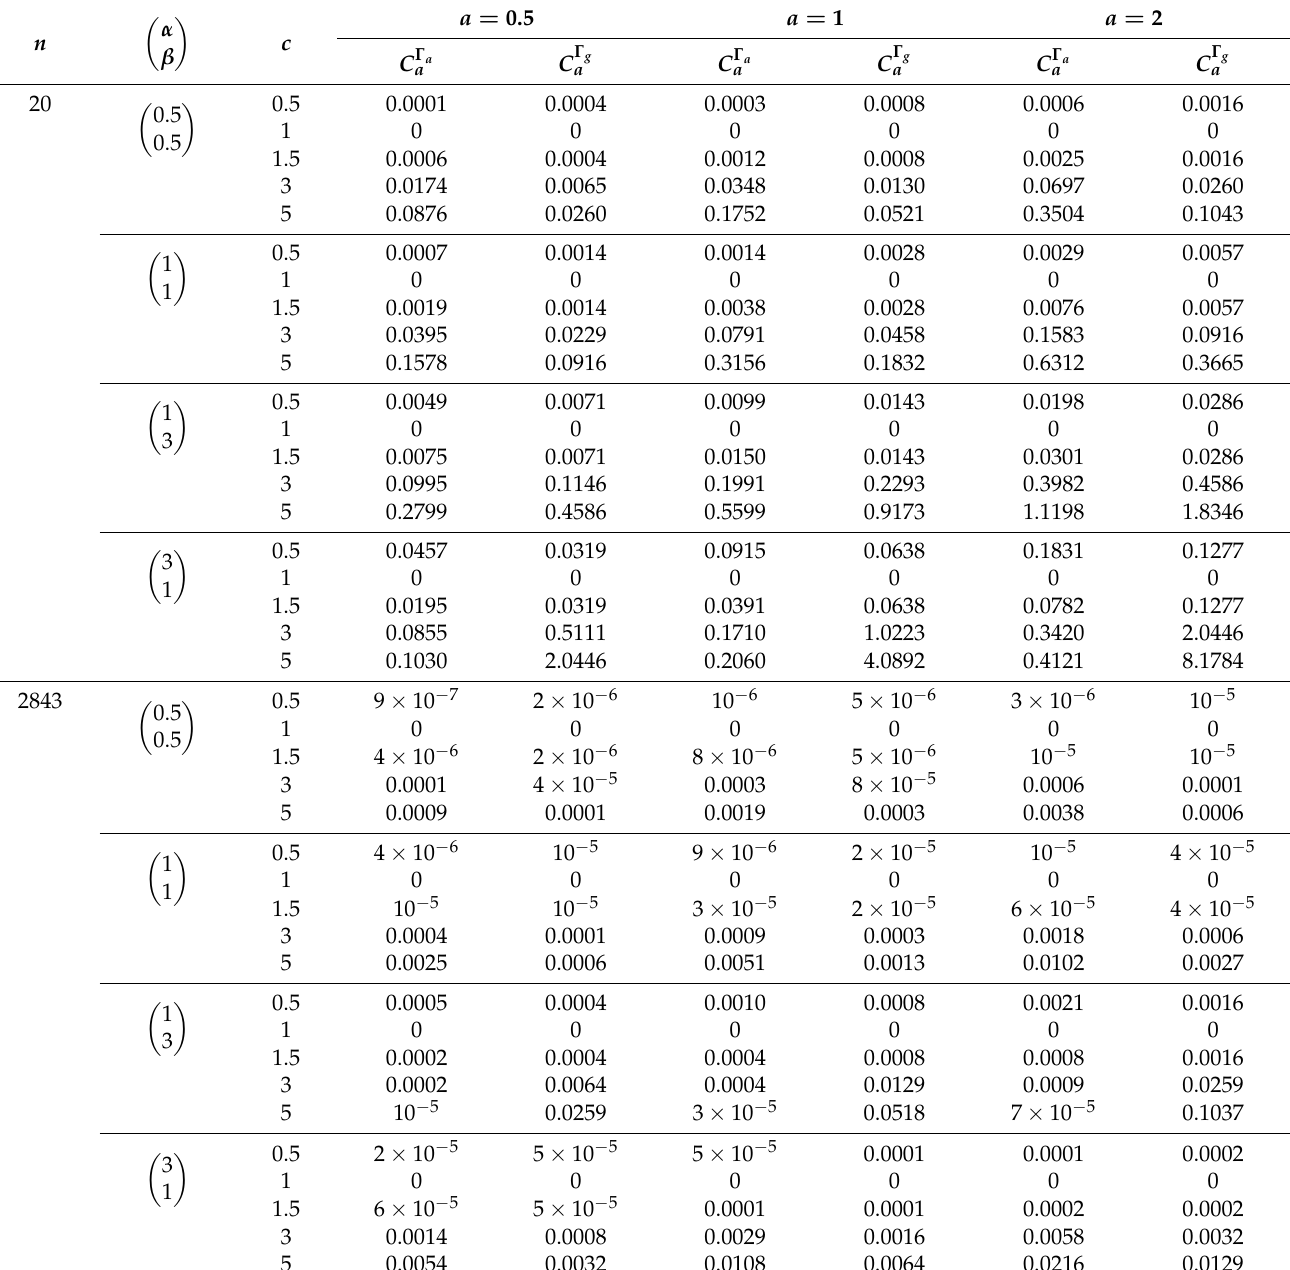
sample of size n = 20, for the whole dataset (i.e., n = 2843), the value of the curvature is small for all cases of α , β and c , demonstrating less effect of the prior in the presence of a large sample size. Table 4. Values of the local curvature for the two classes Γ a and Γ g for the real data set